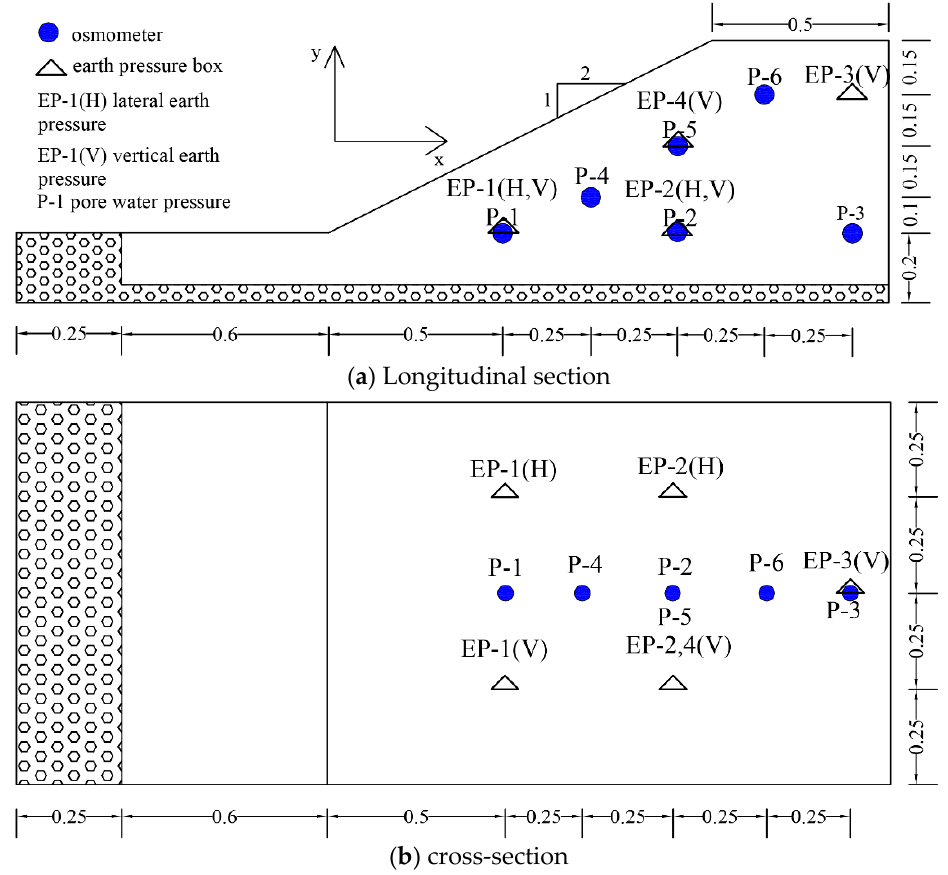
Figure 4. Micro-osmometer and embedded position map of earth pressure box in model test of medium sand slope (m).